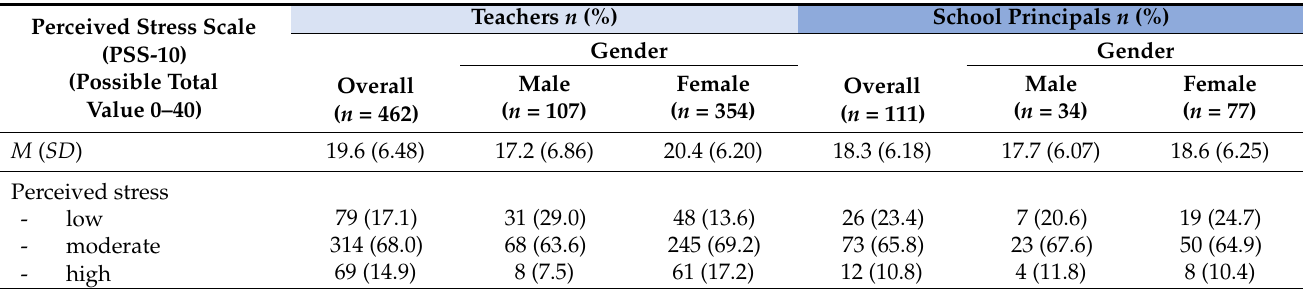
Table 3. Perceived Stress for Teachers and School Principals